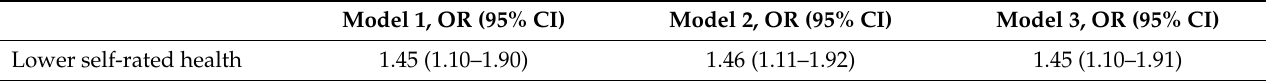
Table 5. The association between lower self-rated health and sick leave in 12